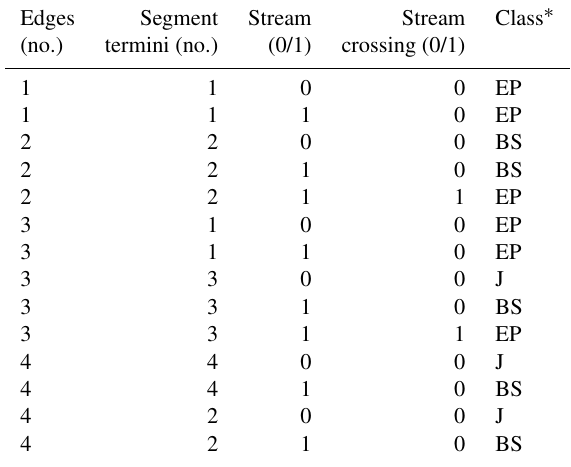
Table A1. Divide node classification